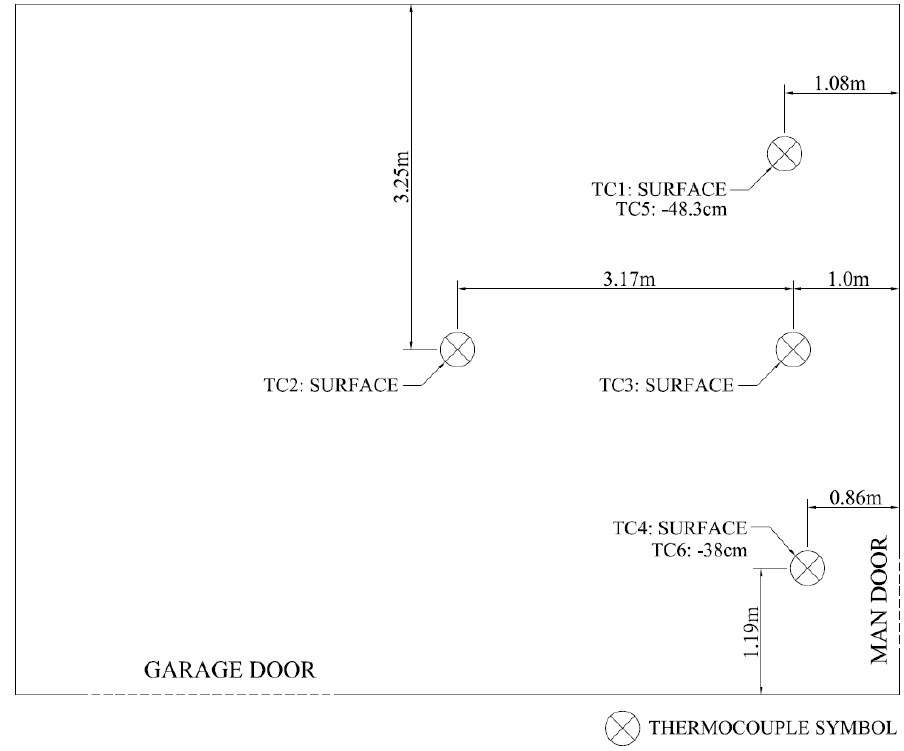
Figure 12. Thermocouple arrangement on sand-bed thermal storage.